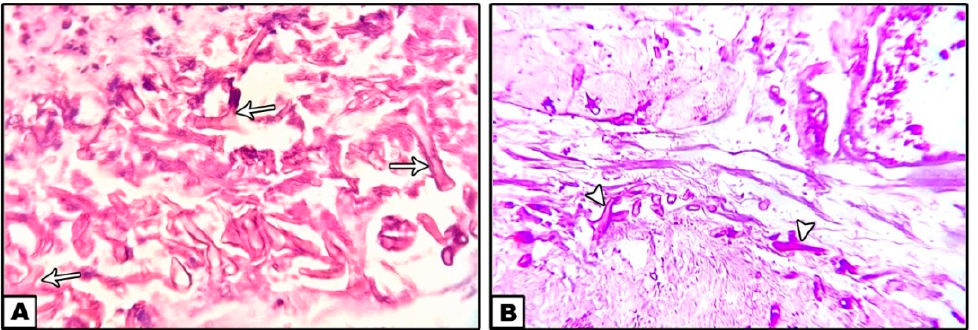
Figure 6. Nonseptate hyphae with right angle branching (arrows) and spores of mucormycosis surrounded by necrotic tissues and a dense inflammatory infiltration. (( A ): H&E ×40, ( B ): PAS ×40).